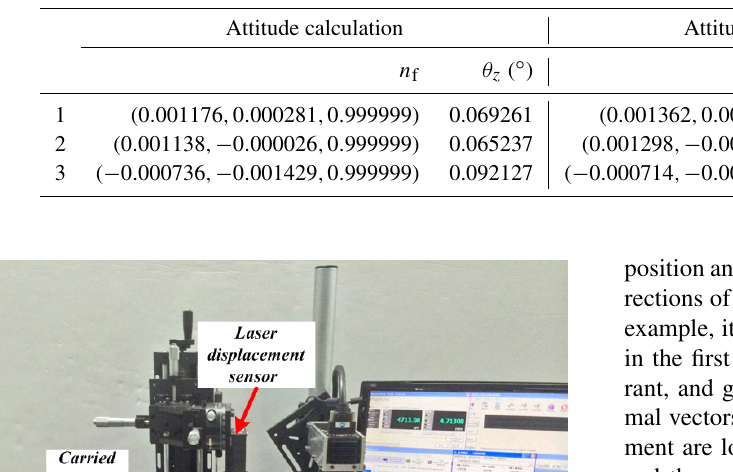
Table 6. Results of the attitude calculation and attitude measurement.